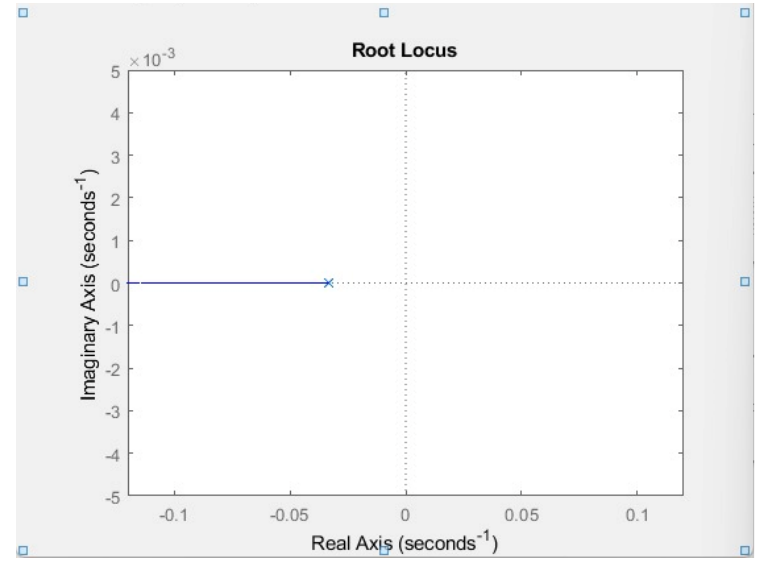
Figure 18. Root locus plot of vapor compression cycle.